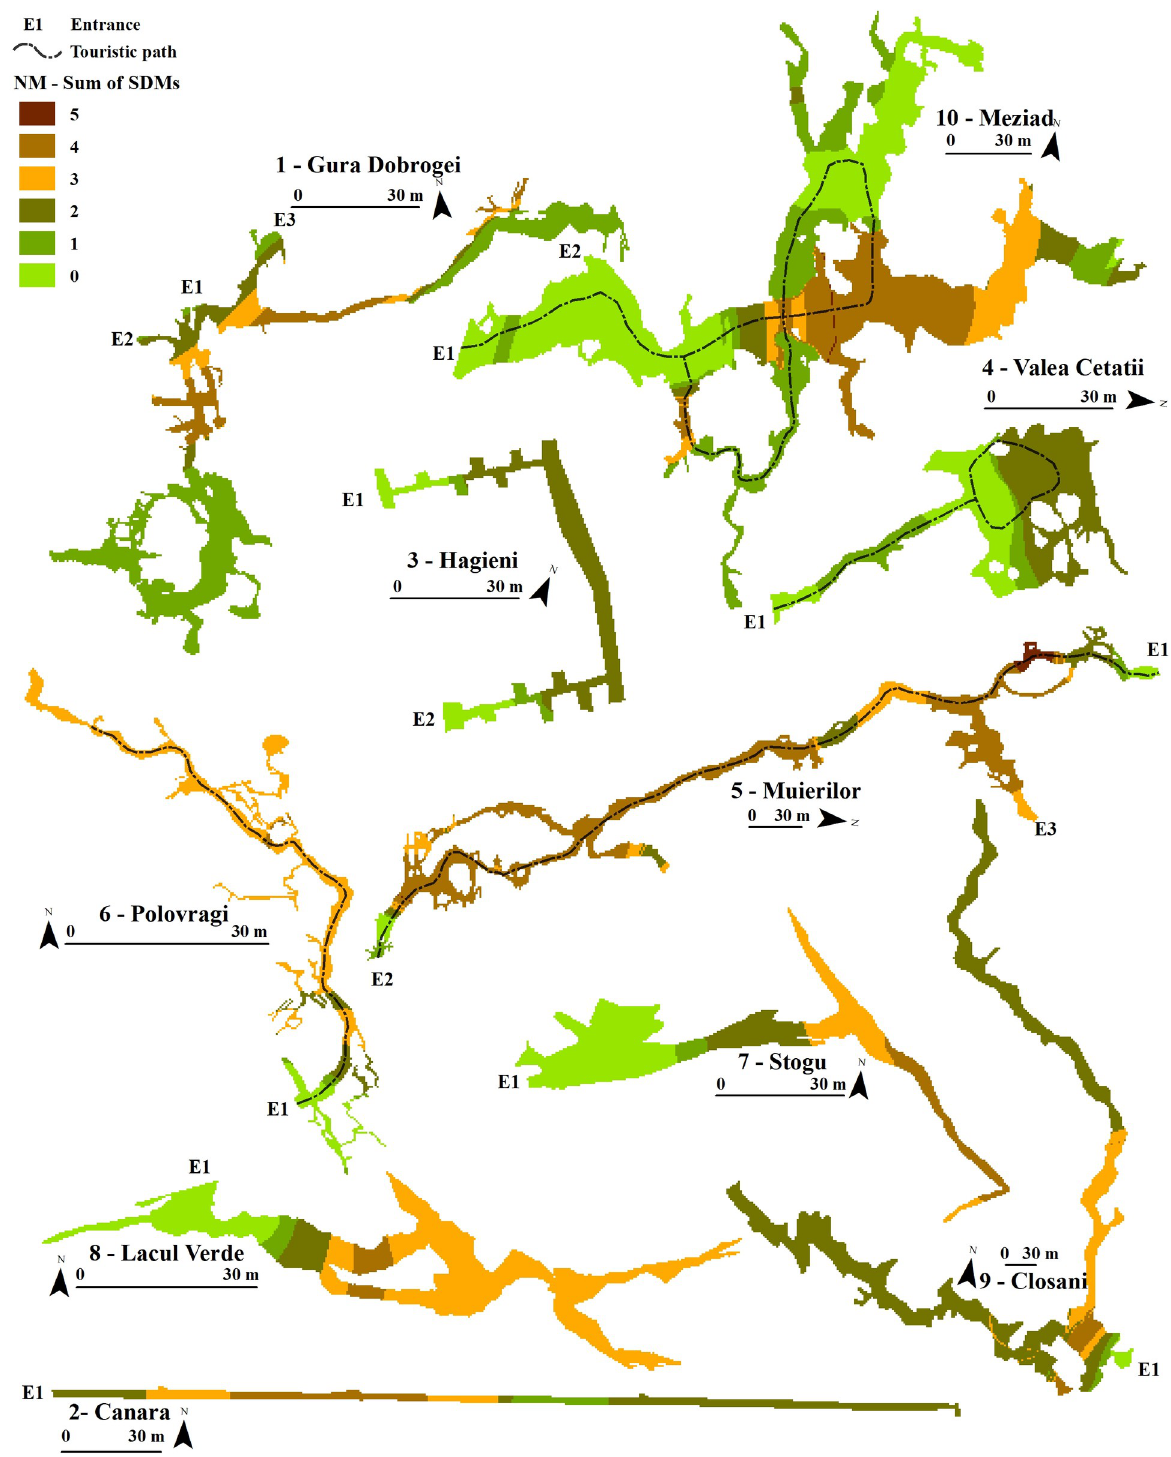
Fig 4. Ensemble SDMs for the November–March (NM)—mid to end hibernation period for all the studied SEs. Sum of SDMs shows the number of suitable habitats which overlap within a SE.